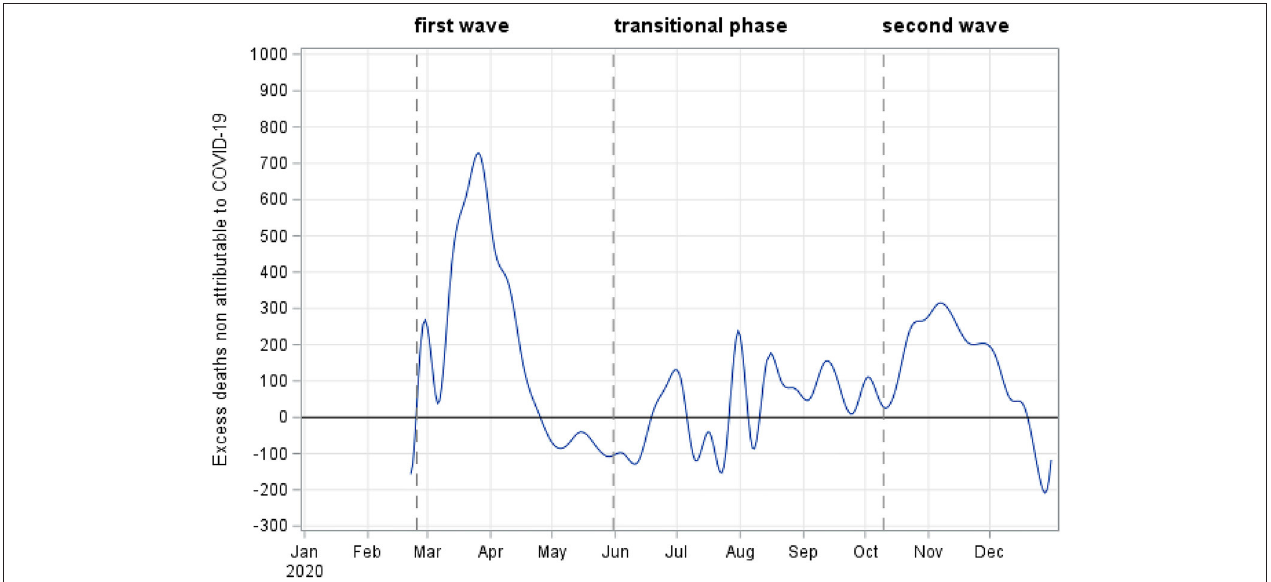
FIGURE 3 | Excess deaths not directly attributable to COVID-19 during the pandemic, Italy - year 2020.